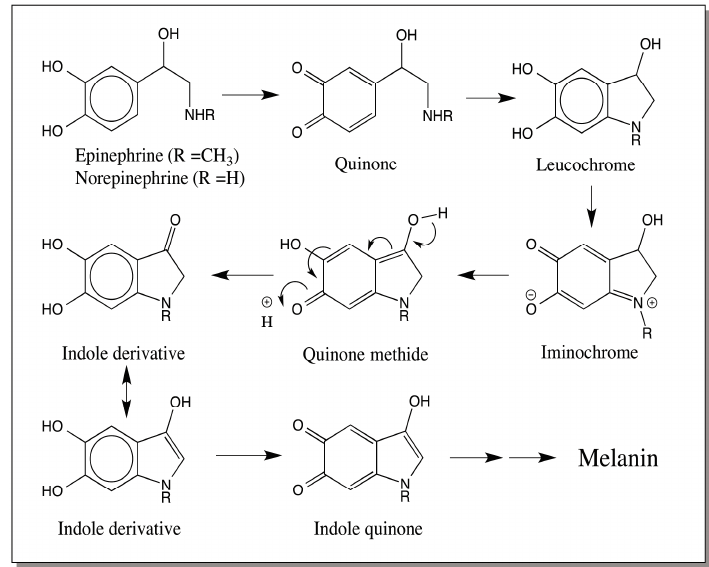
Figure 8. Melanin biosynthesis from epinephrine and norepinephrine. Both epinephrine and norepinephrine can be easily oxidized to their two-electron oxidation product—quinones. These quinones also exhibit rapid intramolecular cyclization producing leucochromes. Conversion of leucochrome to iminochrome and isomerization to quinone methide will result in adrenolutin formation in the case of epinephrine. A similar reaction of norepinephrine to the keto indole derivative has not yet been demonstrated, but is quite possible. Further oxidative transformations of these products will result in melanin production.